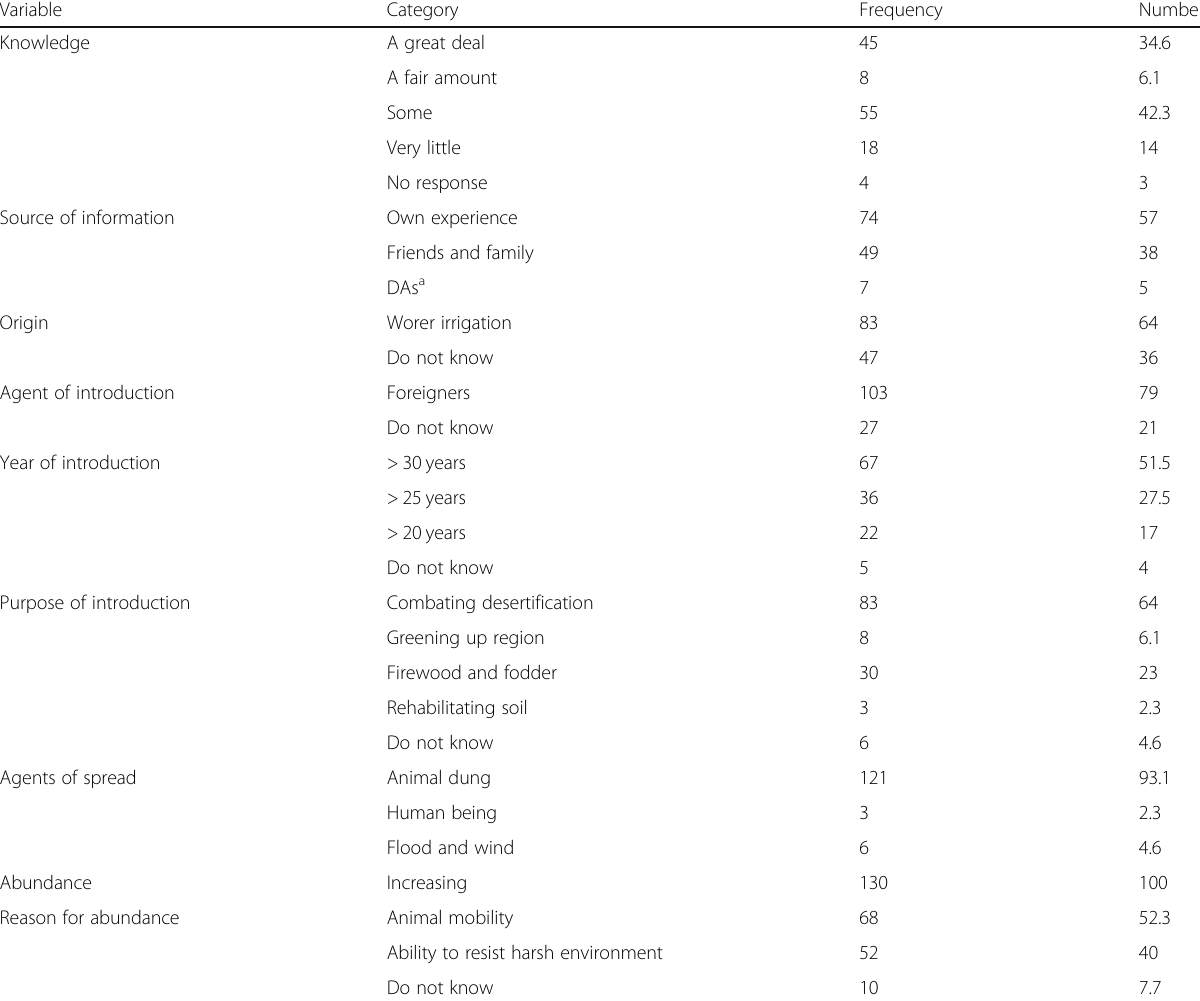
Table 3 Households ’ perceptions about the introduction, abundance and spread of P. juliflora in Amibara district